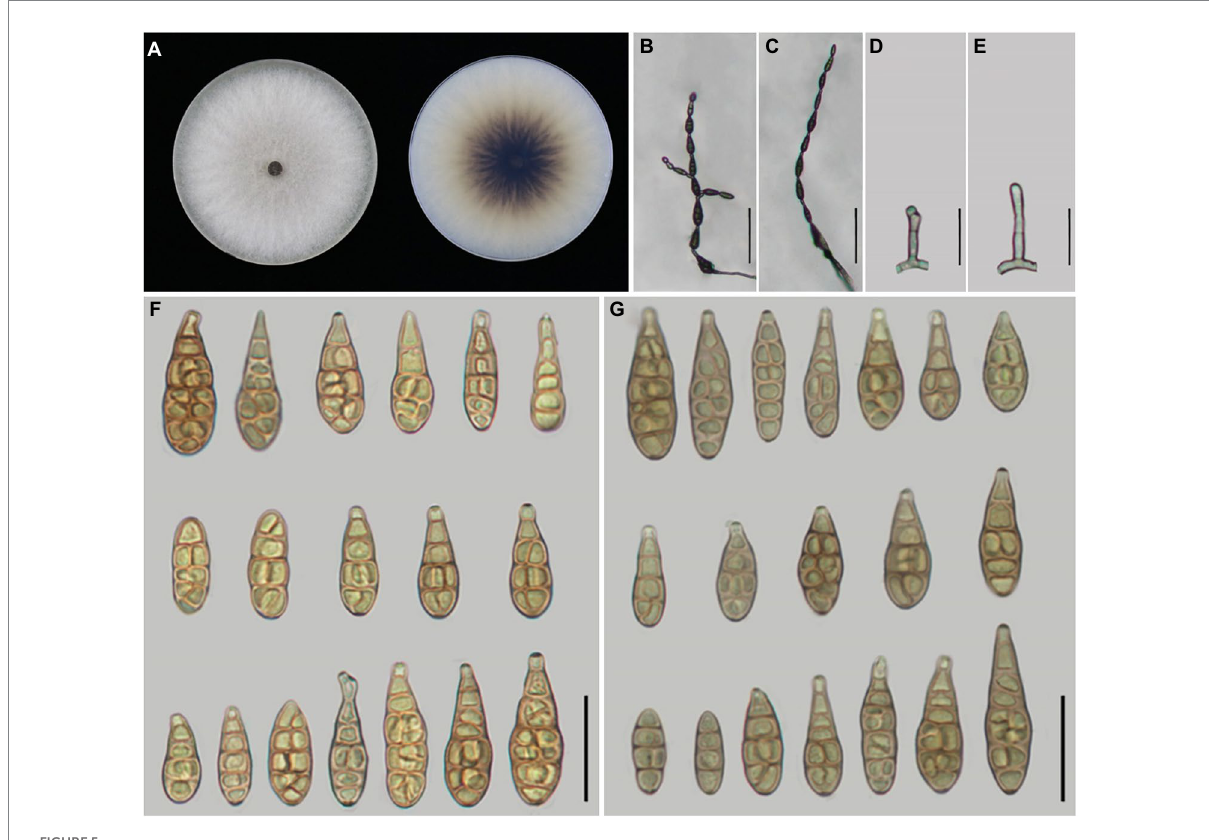
FIGURE 5 Morphology of Alternaria setosae sp. nov. (A) Colony phenotype (on PDA for 7 days at 25 ° C); (B,C) Sporulation patterns (on PCA at 22 ° C); (D,E) Conidiophores; (F) Conidia (on PCA at 22°C); (G) Conidia (on V8A at 22 ° C). Bars: B,C = 50 μ m; D–G = 25 μ